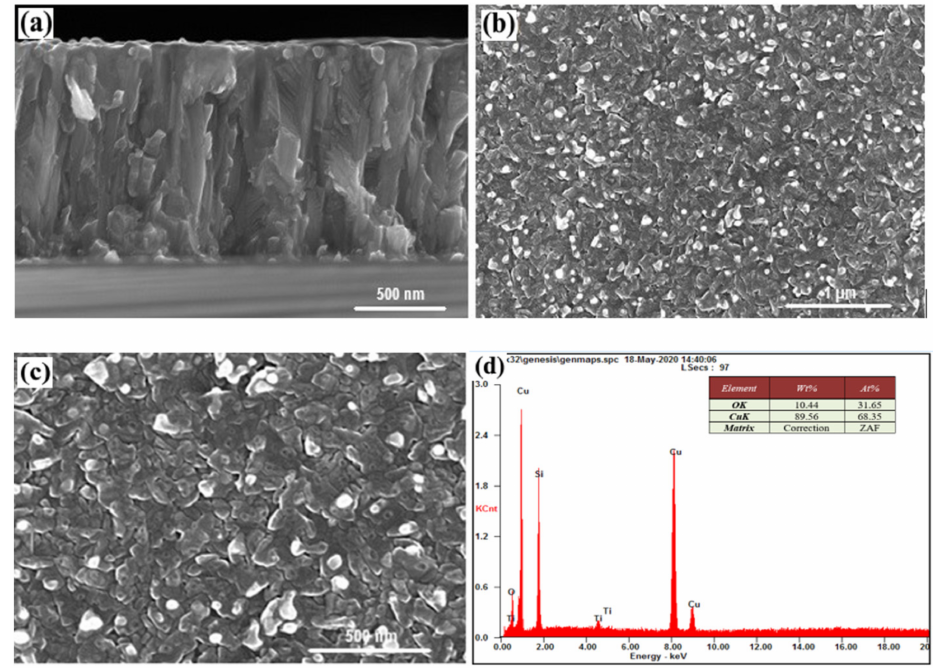
Figure 5. Cross-section ( a ), morphology ( b , c ), and chemical analysis ( d ) of sample #15. Table 4 shows the basic morphological parameters of the deposited thin